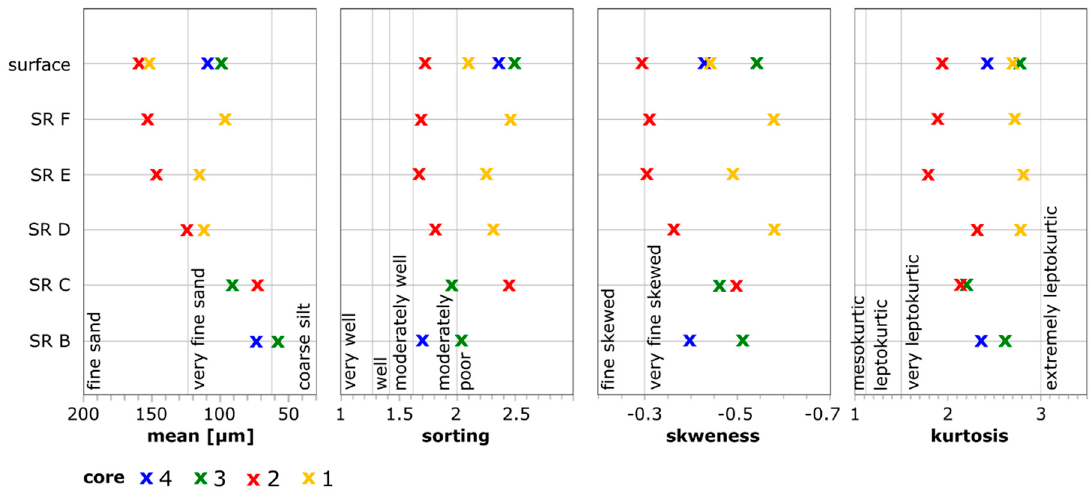
Figure 11. Grain size parameters of certain seismic reflectors and the sediment surface calculated after the modified Folk and Ward method [44]. The individual values represent the mean of samples 5 cm above and below the reflector depth.